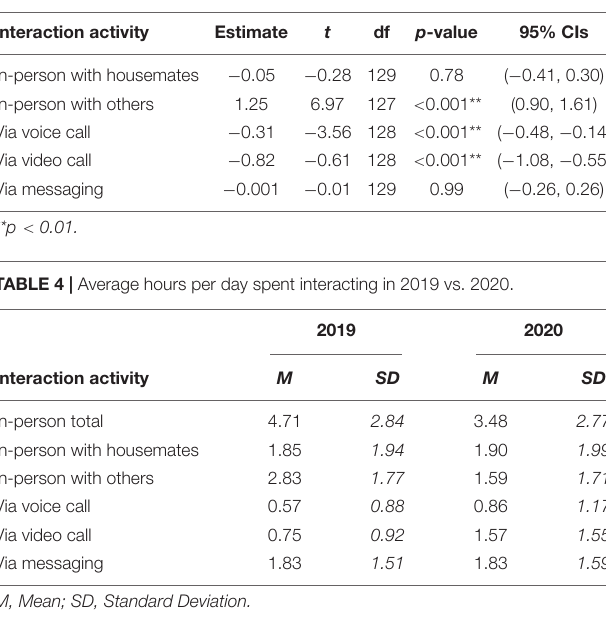
TABLE 3 | T -tests of time spent interacting between 2019 vs. 2020.